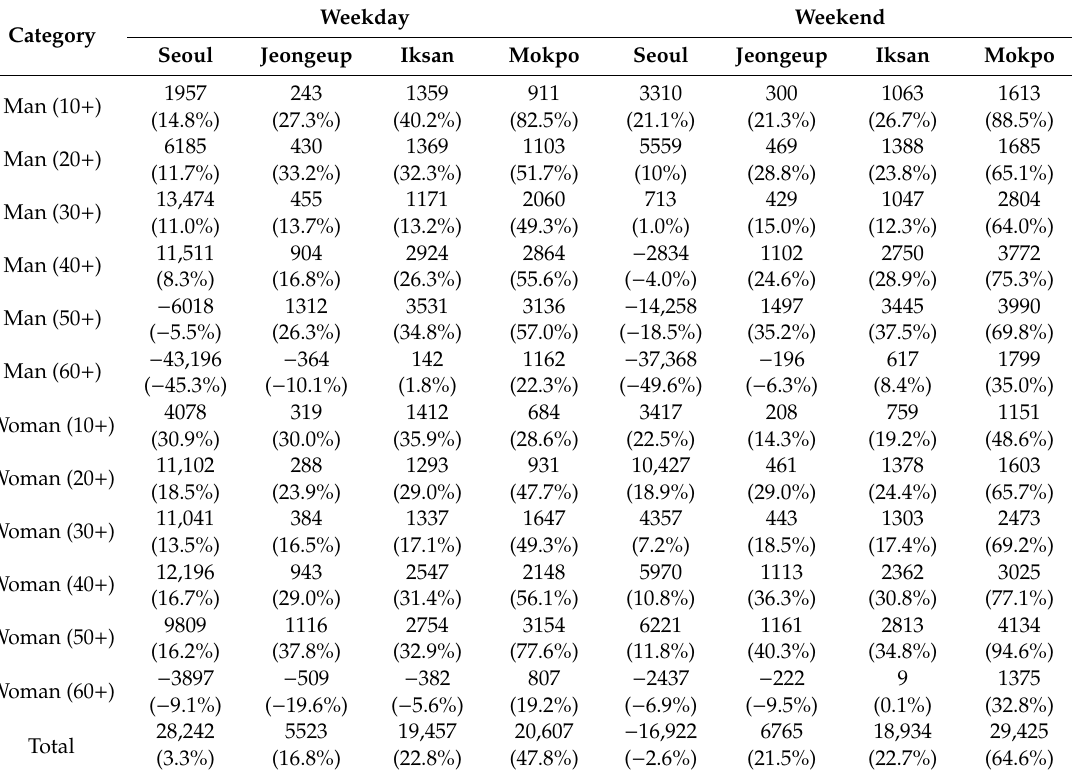
Table 4. Di ff erences of mobile population before and after the opening of HSR at each station. Category